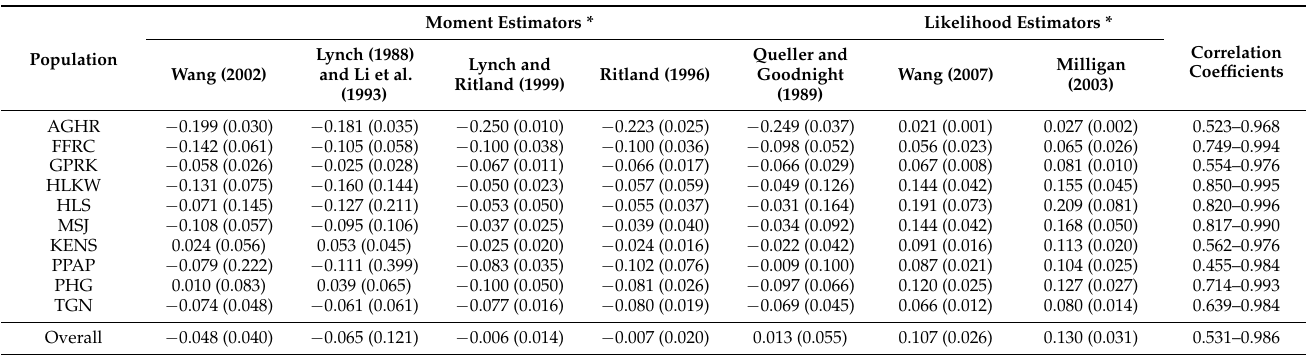
Table 5. Genetic relatedness (R xy ) among individuals within each population and their correlation coefficients based on individuals’ microsatellite (SSR) genotype